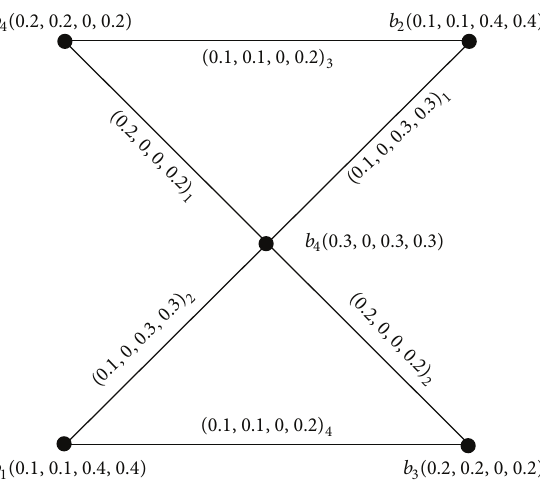
Figure 8: A strong self-complementary 4-PFGS.